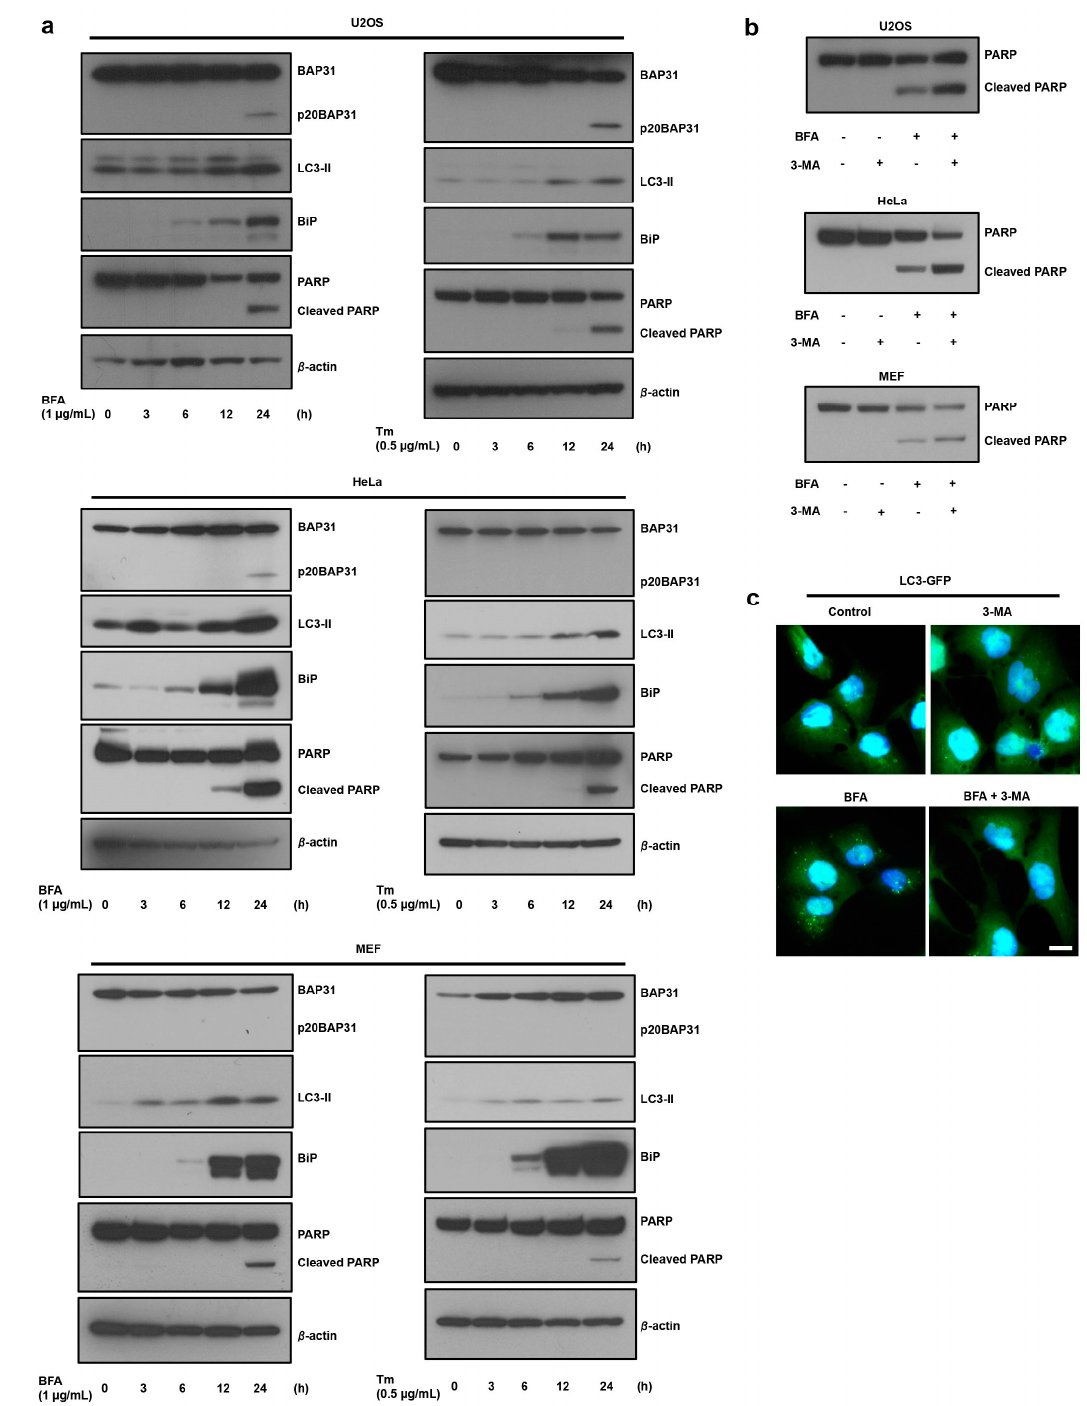
Figure 1. ER stress induces autophagy, which suppressed ER stress-induced cell death. ( a ) ER stress induces cell death and autophagy. U2OS, HeLa, and MEF cells were treated with the indicated compounds at the indicated concentrations for the indicated time. Cell lysates were subjected to immunoblotting using anti-BAP31, anti-LC3, anti-BiP, anti-PARP, and anti- β -actin antibodies. Three independent experiments were done and quantification analysis is shown in Figure S1a. ( b ) The suppression of the induction of autophagy stimulates ER stress-induced cell death. U2OS, Hela, and MEF cells were preincubated with 5 mM of 3-MA for 1 h and further incubated with or without brefeldin A (BFA) (1 µg/mL) for 18 h. Cell lysates were subjected to immunoblotting using anti-PARP antibody. Three independent experiments were done and quantification analysis is